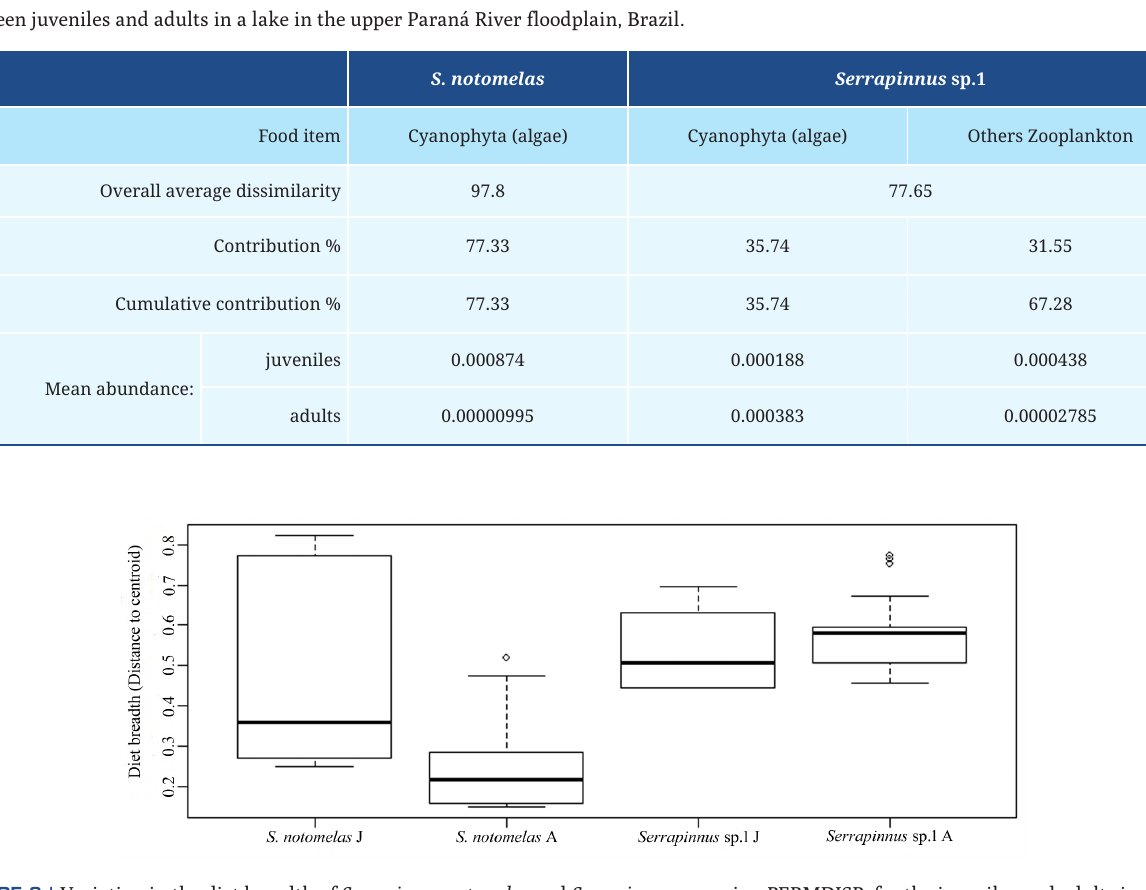
FIGURE 3 | Variation in the diet breadth of Serrapinnus notomelas and Serrapinnus sp.1 using PERMDISP, for the juveniles and adults in a lake in the upper Paraná River floodplain, Brazil. Boxes represent the 25th and 75th quartiles and demonstrate the individual variation of the trophic niche. The horizontal bars in each box represent the average niche breadth. Whiskers indicate the range and individual symbols indicate outliers. J =juveniles; A =